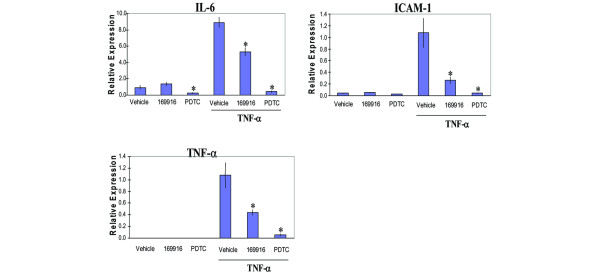
Inhibitory effect of treatment with WAY-169916 on inflammatory gene expression in FLS induced by TNF-α. Fibroblast-like synoviocytes (FLS) were pretreated for 1 hour with WAY-169916 (1 μM) or pyrrolidine dithiocarbamate (PDTC) (100 μM) before treatment with tumor necrosis factor-α (TNF-α) for 1 hour. The mRNA levels for TNF-α, IL-6 and intercellular cell-adhesion molecule-1 (ICAM-1) were determined by real-time RT–PCR and normalized to glyceraldehyde-3-phosphate dehydrogenase. Results are reported as means ± SEM for each group, with the mean level of the stimulated cells treated with vehicle defined as 1. *P < 0.05 compared with vehicle control.